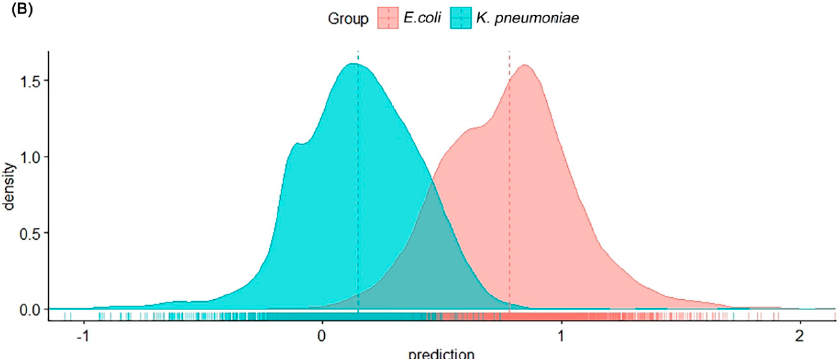
Figure 1. ( A ) Average Near-Infrared Spectroscopy (NIRS) spectra in the 350 to 2500 nm region from K. pneumoniae (red) and E. coli (black) and ( B ) density plot showing NIRS differentiation of E. coli (Pink) and K. pneumoniae (Blue) using test samples.